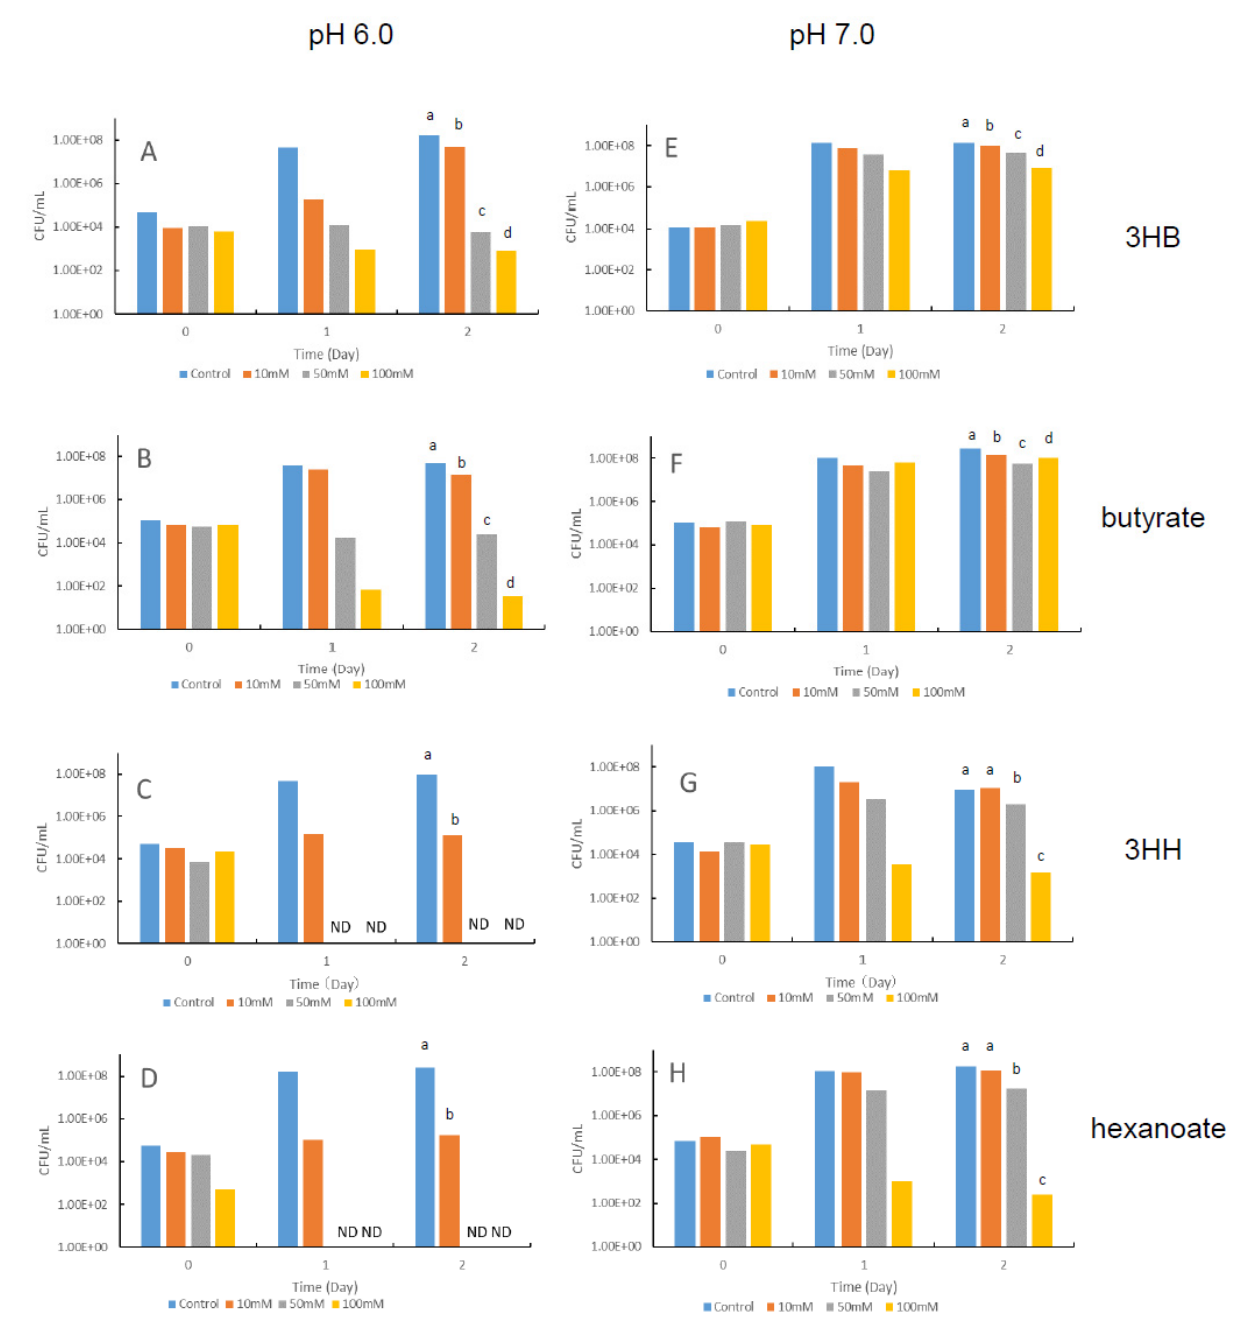
Figure 2. Growth of the shrimp-pathogenic bacterium Vibrio penaeicida in nutrient medium containing different concentra- tions of the hydroxyalkanoic acids 3-hydroxybutyrate (3HB) ( A , E ) or 3-hydroxyhexanoate (3HH) ( C , G ), or the fatty acids butyrate ( B , F ) or hexanoate ( D , H ) at pH 6.0 (left half) or 7.0 (right half). CFU: colony-forming units; ND: not detected. Different superscript letters in each figure show significant differences ( p < 0.05).